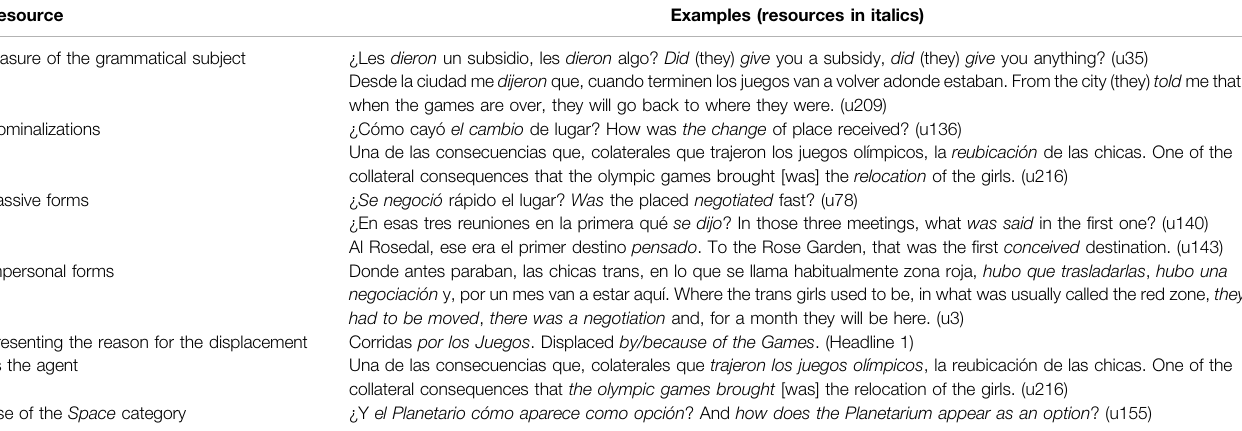
TABLE 10 | Mitigating resources that affect the Government of the City of Buenos Aires as an agent.